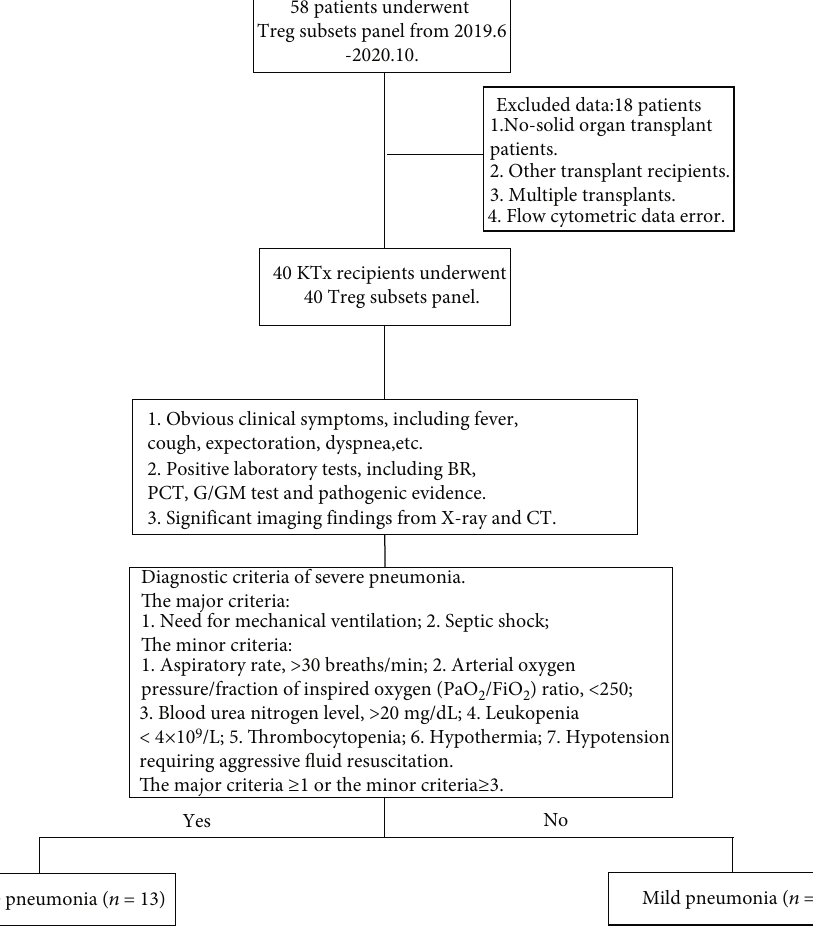
Figure 2: The study fl owchart and exclusion criteria. 13 severe pneumonia and 27 mild pneumonia kidney transplant recipients were fi nally enrolled for